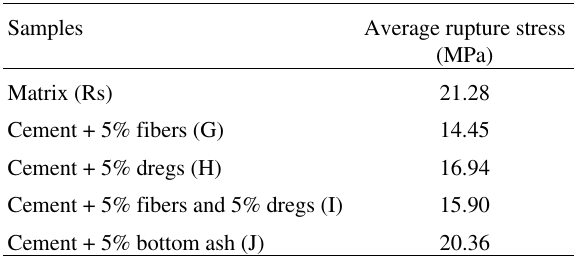
Table 5. Average strength of the samples prepared with CPI-S-32 Port- land cement after an aging time of 28 days. Amount of waste in volume